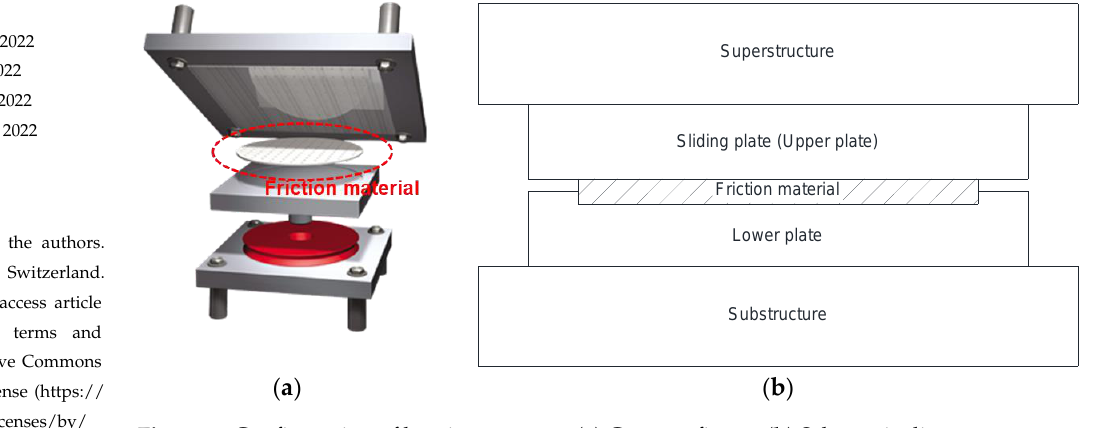
( b ) Figure 2. Corrosion of bearing supports: ( a ) high-strength brass friction material rust; ( b ) corrosion of bearing supports due to rust. To overcome these problems, the current friction materials in most bearing supports are engineering plastic (EP), ultra-high molecular weight polyethylene (UHMWPE) and polytetrafluoroethylene (PTFE). Through the analysis of the high-speed railway PSC box bridge, Oh et al. [9] selected a 40 m simple span and a two-span continuous bridge as representative types and reviewed the travel distance by live load by applying PTFE. The distance traveled by live load was considered as a major factor in EN1337-2 [10], but the accumulated distance by live load for one year was 145 m, significantly exceeding 10 m by temperature load. Recently, PTFE has been replaced by EP due to the excellent properties of EP and UHMWPE [11 – 14]. Even if EP develops relatively higher friction coefficient than that of PTFE, it offers higher durability and allowable bearing resistance. Notably, a long-term friction test showed that the sliding distance of EP is 2 to 5 times longer than that of PTFE [15] with a 3 times higher friction coefficient [16 – 20]. Such types of friction materials are lubricated to make smoother behavior between upper and lower bearing plates. However, the longer the service period of structures, the lower the lubrication performance of fric- tion materials due to the loss of lubricant or deformation of friction materials. Any damage of the friction material can degrade the structural performance of structures. In such case, the entire bearing support must be replaced since the friction material cannot be replaced separately, which translates into an increased maintenance cost and an increased life-cycle cost of the structures.